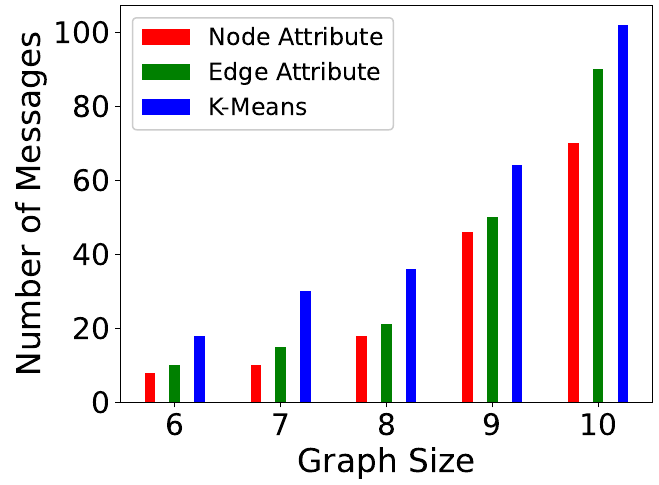
Figure 8. Messages sent for P-TSP.